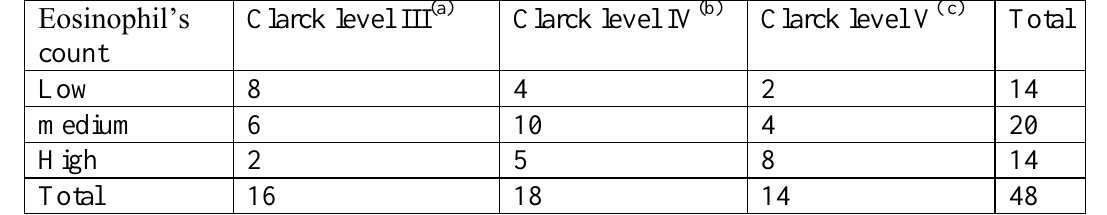
Table 2: Correlation of stromal eosinophilia and level of invasion in conventional squamous cell carcinoma